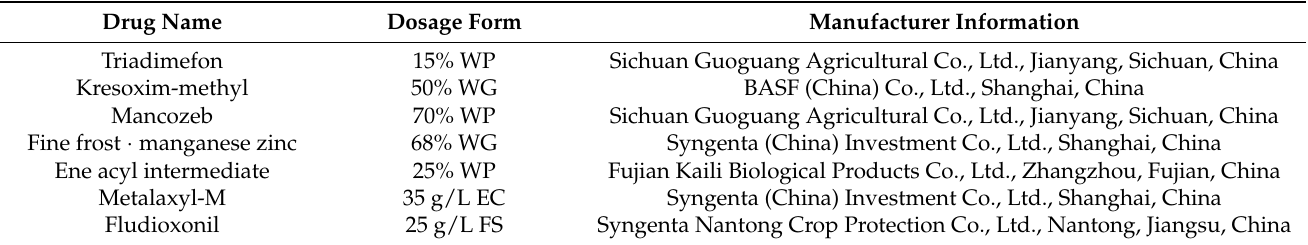
Table 2. Information on the seven fungicides used in the